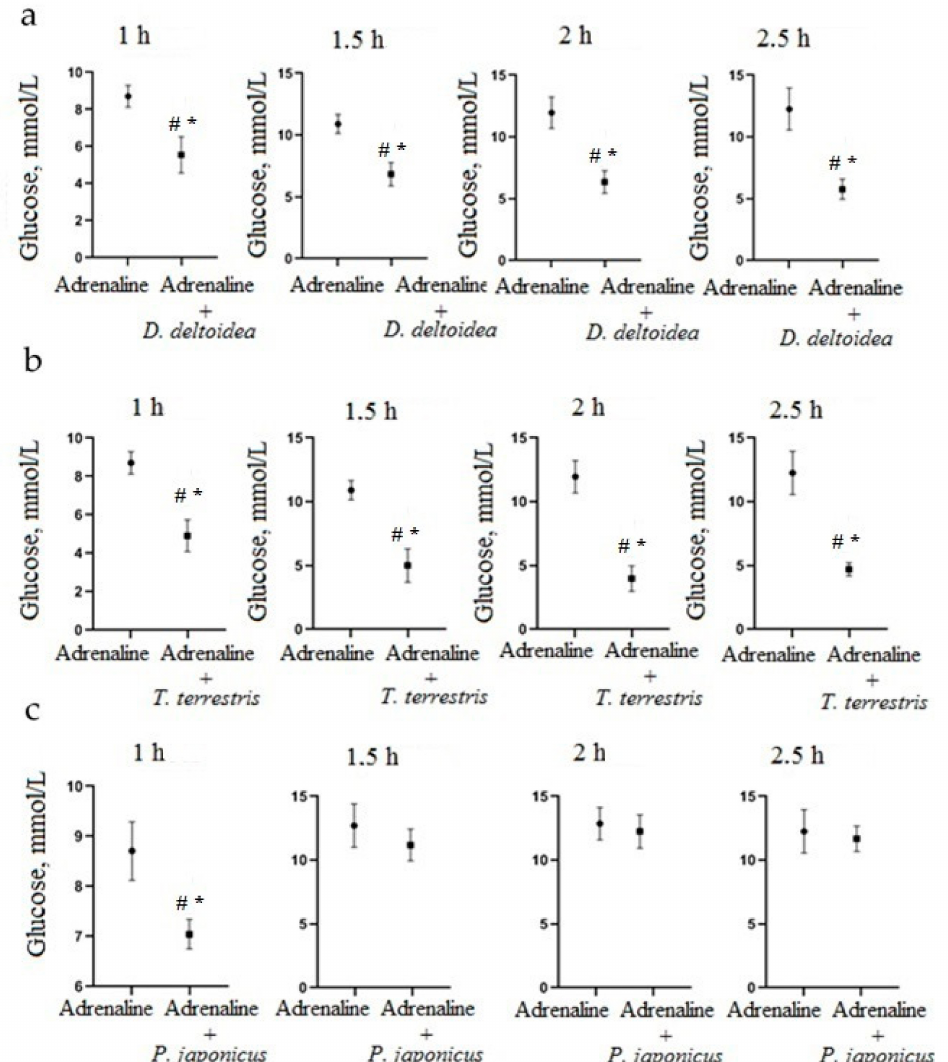
Figure 3. Change of glucose level in blood after a peritoneal administration of adrenaline hydrochloride solution at a dose of 1 mg/kg and oral pre-administration of suspension cells at a dose of 100 mg/kg: ( a ) D. deltoidea , ( b ) T. terrestris and ( c ) P. japonicus . * Significantly different from the adrenaline hydrochloride group; # significantly different from the control